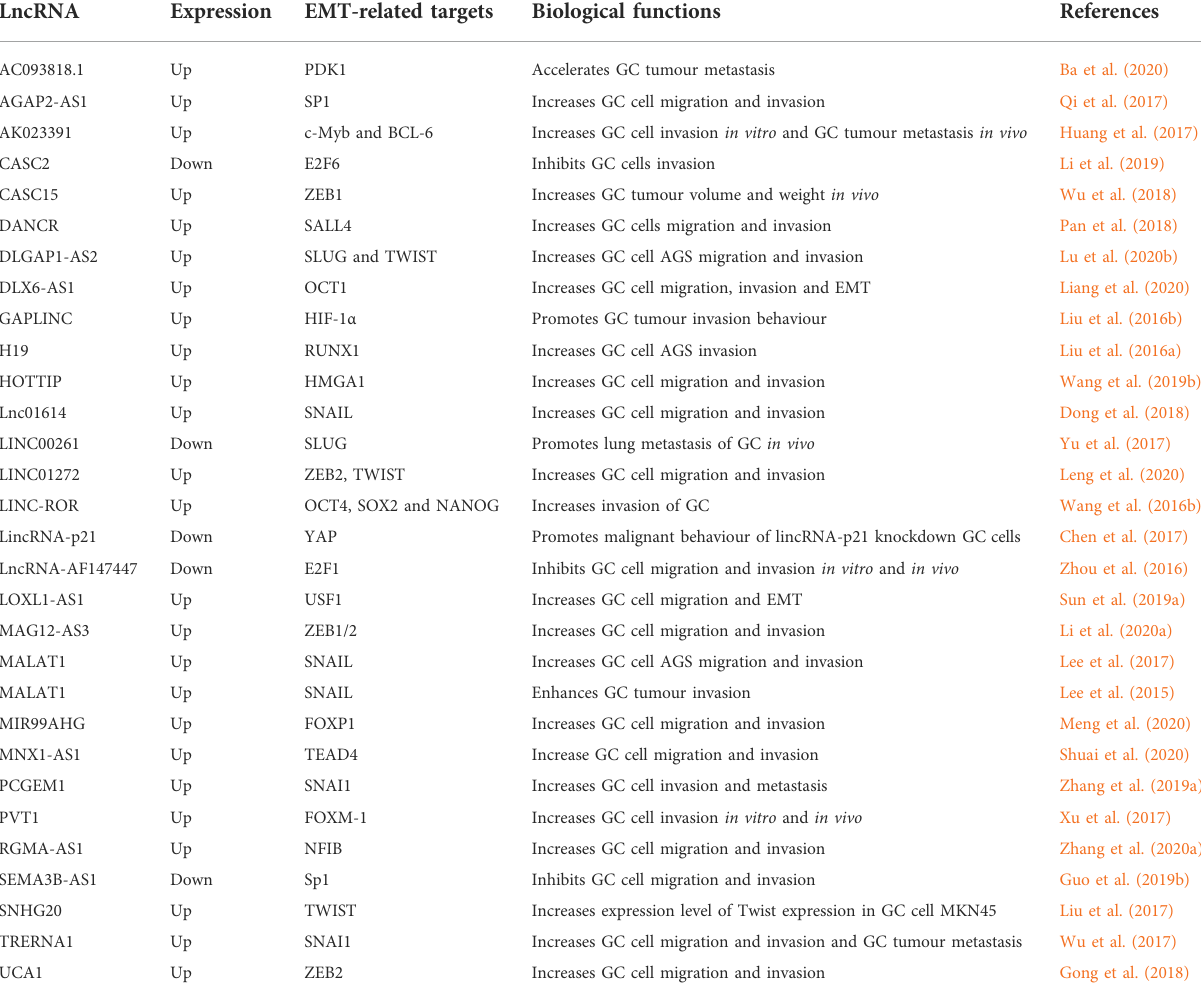
TABLE 2 LncRNAs and their associated transcription factors in the regulation of EMT-induced metastasis in gastric cancer.